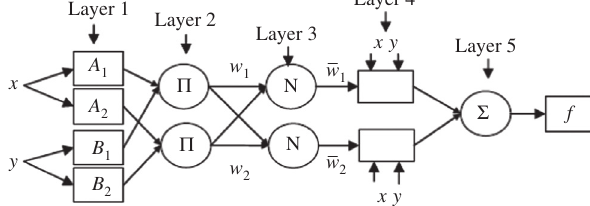
Figure 11 Schematic of ANFIS architecture